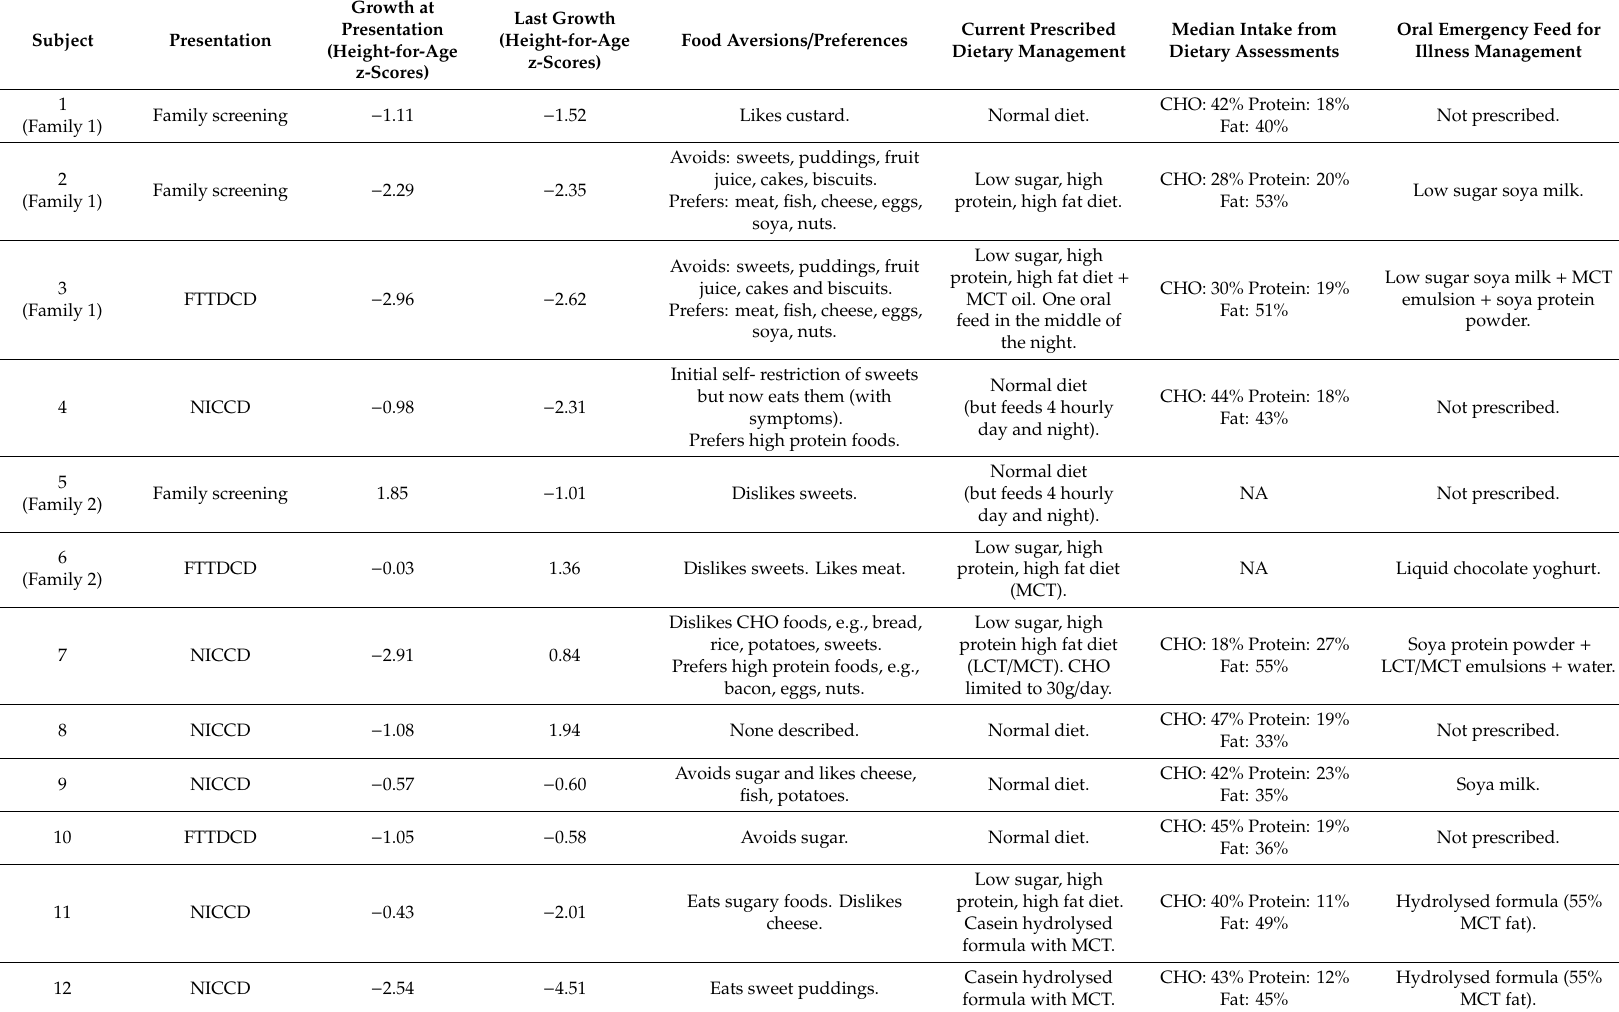
Table 5. Dietary treatment, food preferences / aversions and growth parameters of all study